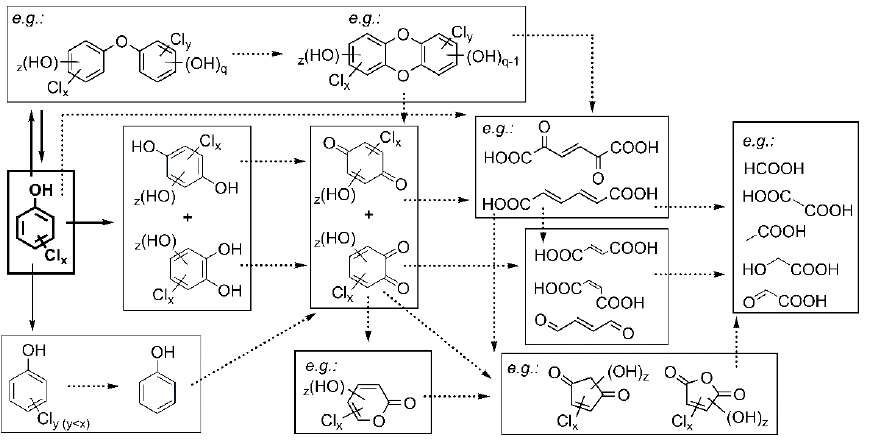
Figure 4. General scheme of the suggested degradation process during ozonation (partially adopted from [6,16–21,24,28]).